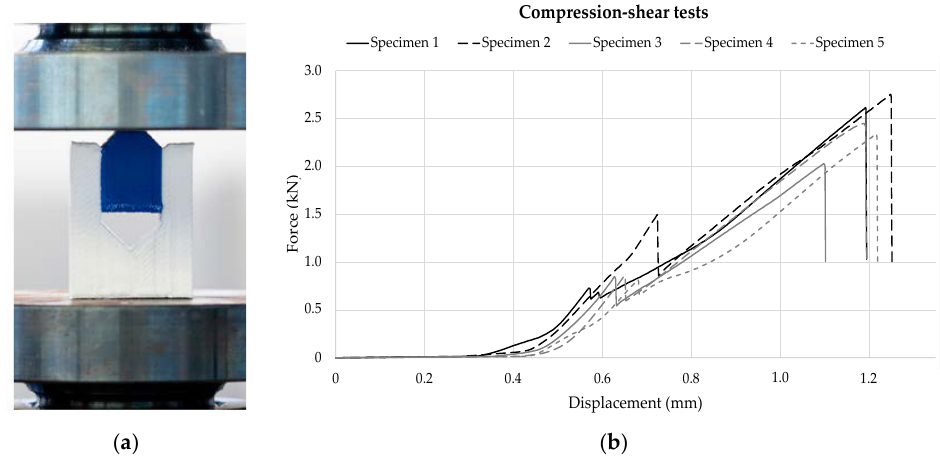
Figure 10. ( a ) Testing set-up of the compression-shear tests with the clamped multi-material test specimen made of PLA (white) and ABS (blue), and ( b ) corresponding force-displacement curve recorded by Instron.